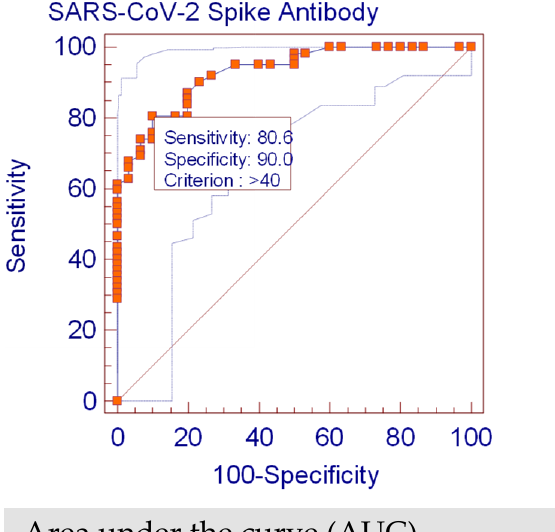
Of the 92 vaccinated participants, 62 (67.4%) tested positive for both anti-S and nAbs. Among those with positive anti-S results, 26 participants (n = 29.5%) were negative for nAbs. None of those with positive nAbs had a negative result for anti-S (Table 1). As shown in the ROC curve, anti-S was found to be a good indicator for the cases with positive nAbs (area under the curve = 0.929). The ROC showed that when the anti-S titer was greater than 40 RU/mL (128 BAU/mL), nAbs were also positive, with sensitivity of 80.6% (95% CI: 68.6%–89.6%) and specificity of 90% (95% CI: 73.5%–97.9%) (Figure 2).